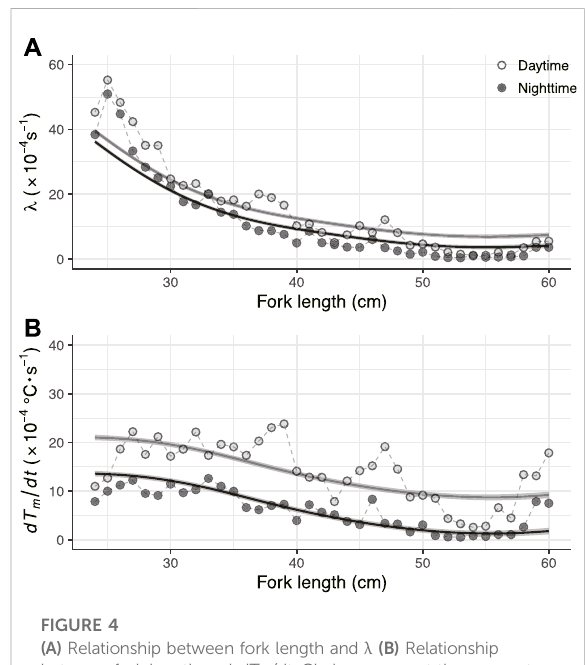
FIGURE 4 (A) Relationship between fork length and λ (B) Relationship between fork length and dT m /dt . Circles represent the parameters estimated semi-daily by the heat-budget model. Pale and dark gray colorsindicatethedataobtainedinthedaytimeandnighttime, respectively. The smooth linesrepresentthe fi ttedlinesforID 2012- 0925 predicted by the generalized additive mixed model.